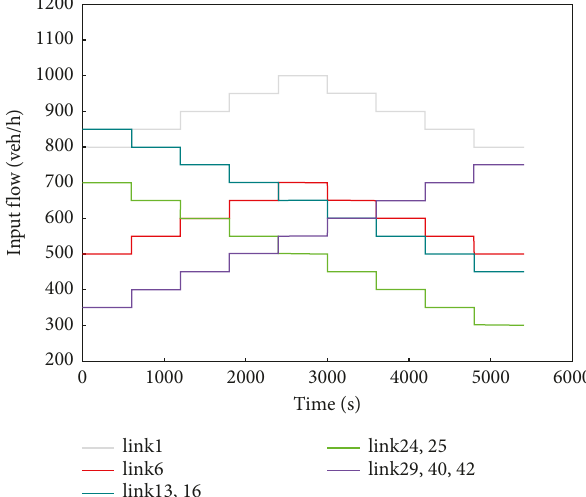
Figure 7: Input flow to the simulation network.